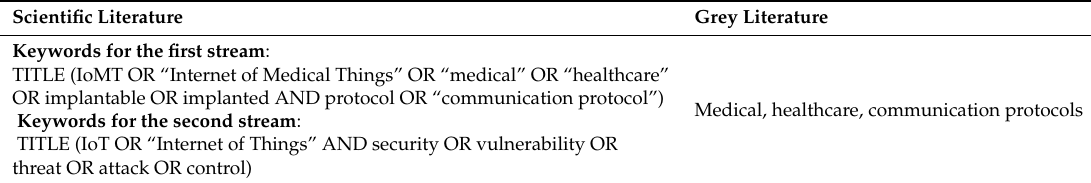
Table 1. Key words used during the search